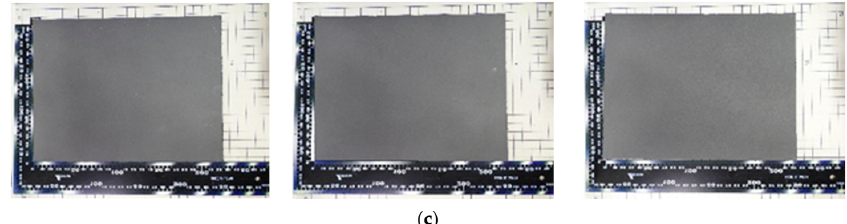
Figure 4. Each sample used for verification: ( a ) CNT spray paint. Coating thickness: 16 µ m [left], 35 µ m [middle], 76 µ m [right]; ( b ) Carbon black paint: Coating thickness: 16 µ m [left], 35 µ m [middle], 76 µ m [right]; ( c ) Graphite paint: Coating thickness: 15 µ m [left], 36 µ m [middle], 74 µ m [right].